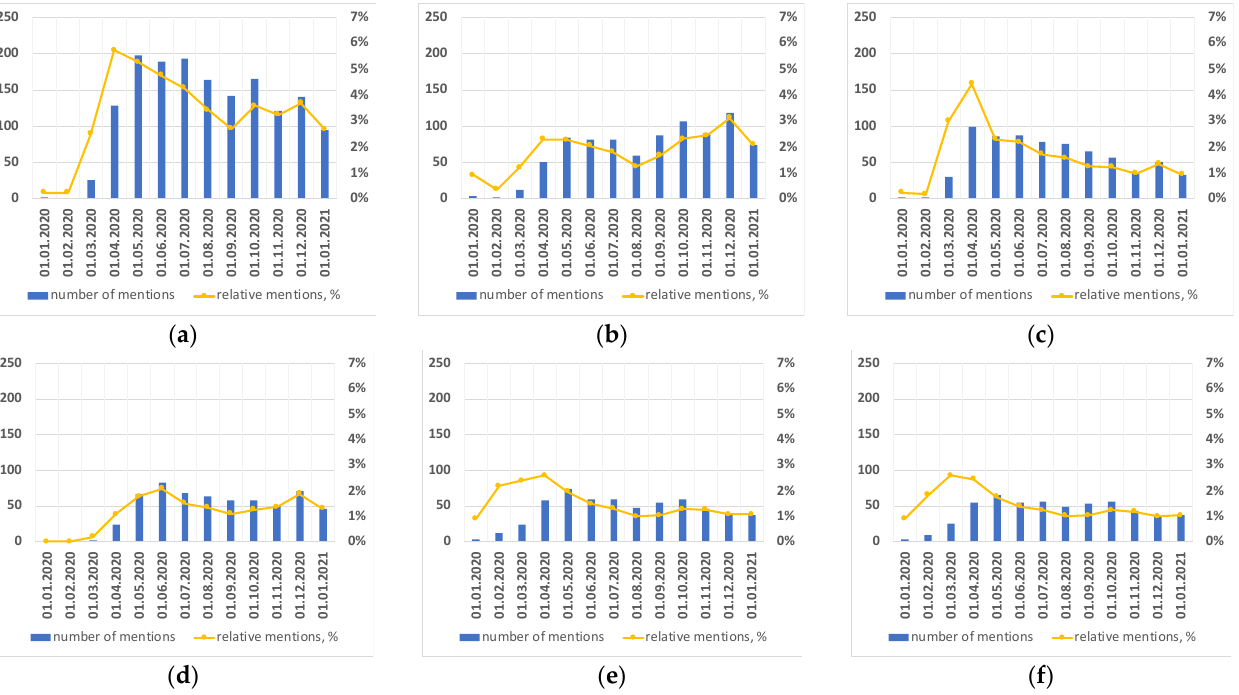
Figure 6. Number of monthly mentions of medications (blue histogram, left y -axis ) and percentage of mentions w.r.t. all articles (yellow solid line, right y -axis) ( a ) hydroxychloroquine (UMLS ID C0020336); ( b ) remdesivir (UMLS ID C4726677); ( c ) chloroquine (UMLS ID C0008269); ( d ) tocilizumab (UMLS ID C1609165); ( e ) lopinavir (UMLS ID C0674432); ( f ) ritonavir (UMLS ID C0292818).